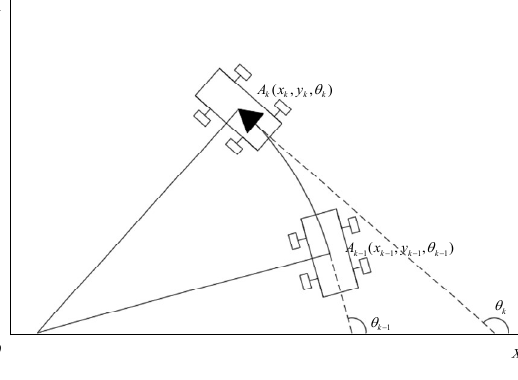
Figure 1. Motion model of mobile robot.